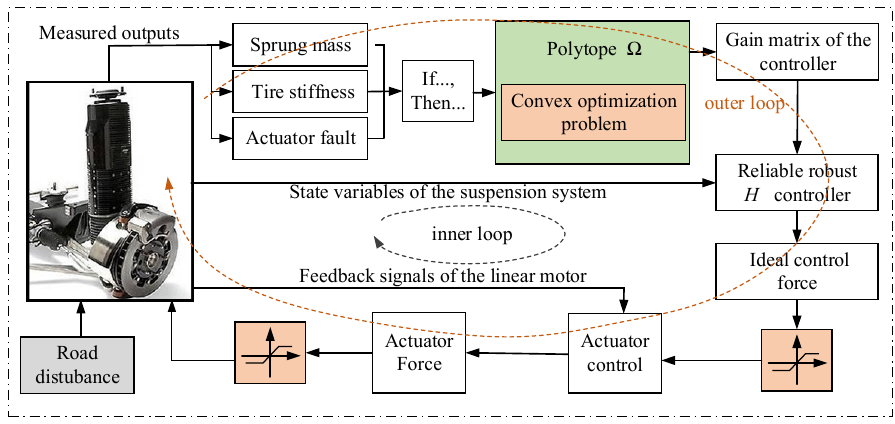
Figure 7. Control structure of the active suspension system.